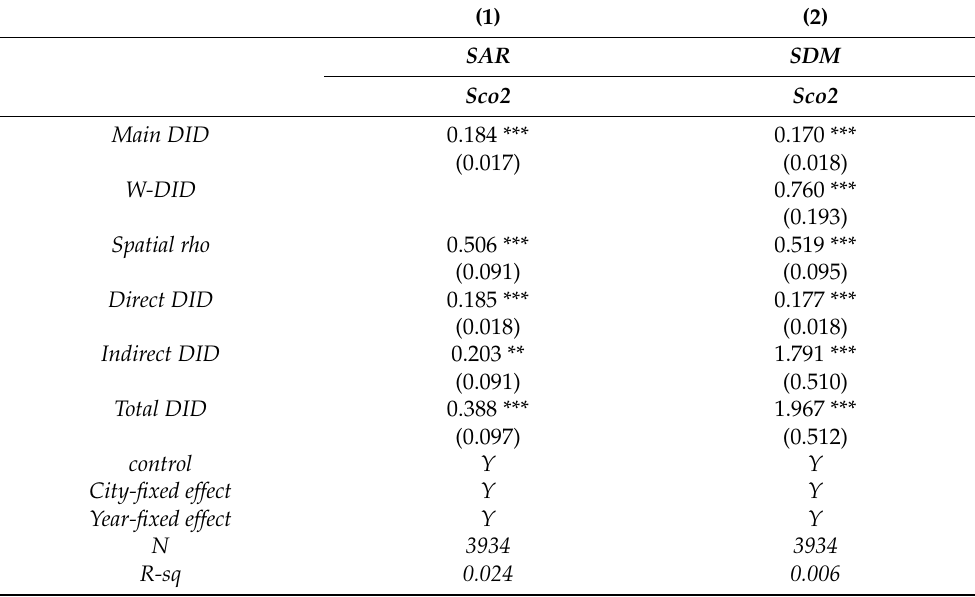
Table 12. Spatial Effect Test of the Innovative City Pilot